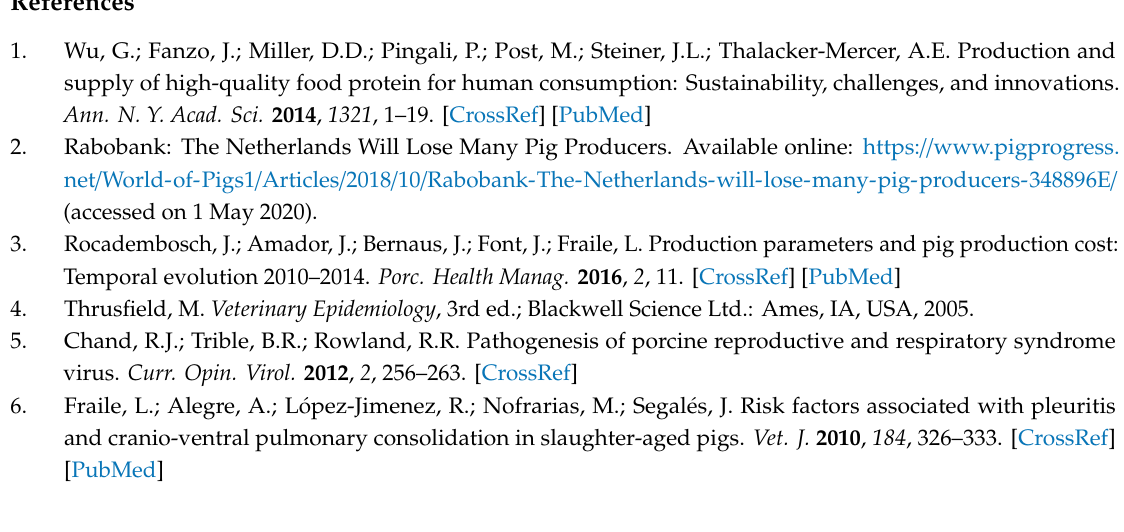
Figure S1: Nursery sick (A) and fattening sick animals (B), depending on the type of management, the percentage of infected animals at vaccine application and the percentage of vaccinated animals; Figure S2: Nursery sick (A) and fattening sick animals (B), depending on the day of vaccination and the percentage of infected animals when the vaccine is applied to 100% of the population; Table S1: Production parameters used to run the model in a 1000-sow farm; Table S2: Average values of viable, sick animals and the consequent weight loss at the end of the nursery and fattening period depending on the percentage of infected and vaccinated animals; Table S3: Average values of viable, sick animals and the consequent weight loss at the end of the nursery and fattening period depending on the percentage of infected and the day of vaccination of the whole population (100% of the animals) versus the infection